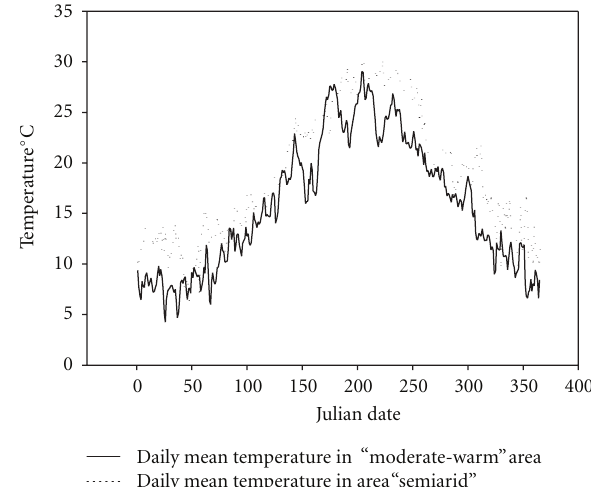
Figure 2: Daily mean temperature of temperate climate (Sicily), years 2005, 2006, and 2007; daily mean temperature of semiarid climate (Calabria), years 2008 and